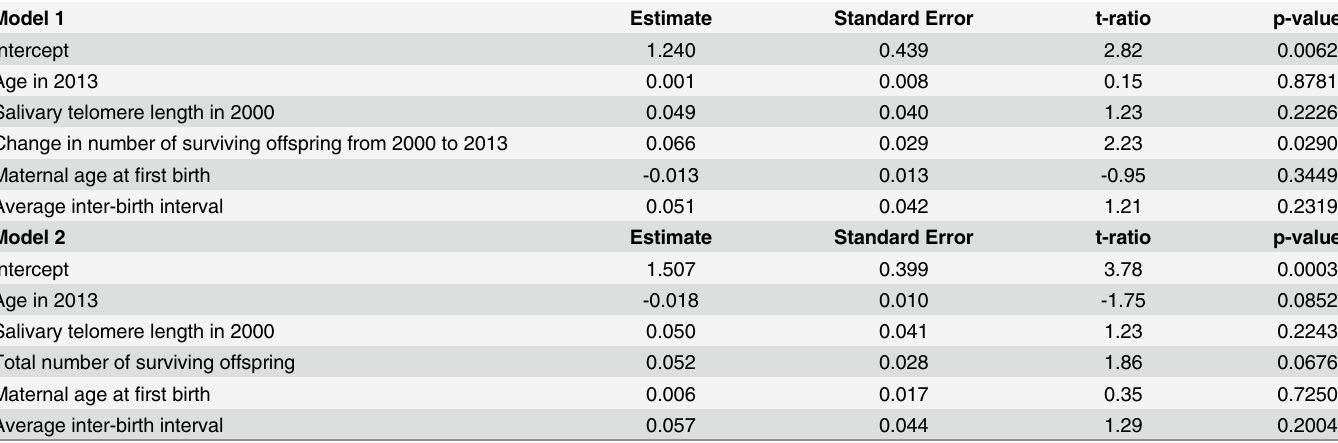
Table 2. Relationship between telomere length in 2013 and women ’ s reproductive history variables. Model 1: Change in number of surviving off- spring from 2000 to 2013 was positively associated with telomere length in 2013, controlling for salivary telomere length in 2000 and maternal age in 2013 (n = 75; adjusted R 2 = 0.041). Model 2: Total number of surviving offspring was marginally positively associated with telomere length in 2013, controlling for salivary telomere length in 2000 and maternal age in 2013 (n = 75; adjusted R 2 = 0.021). Neither maternal age at first birth nor average inter-birth interval was associated with telomere length in 2013 in either model.